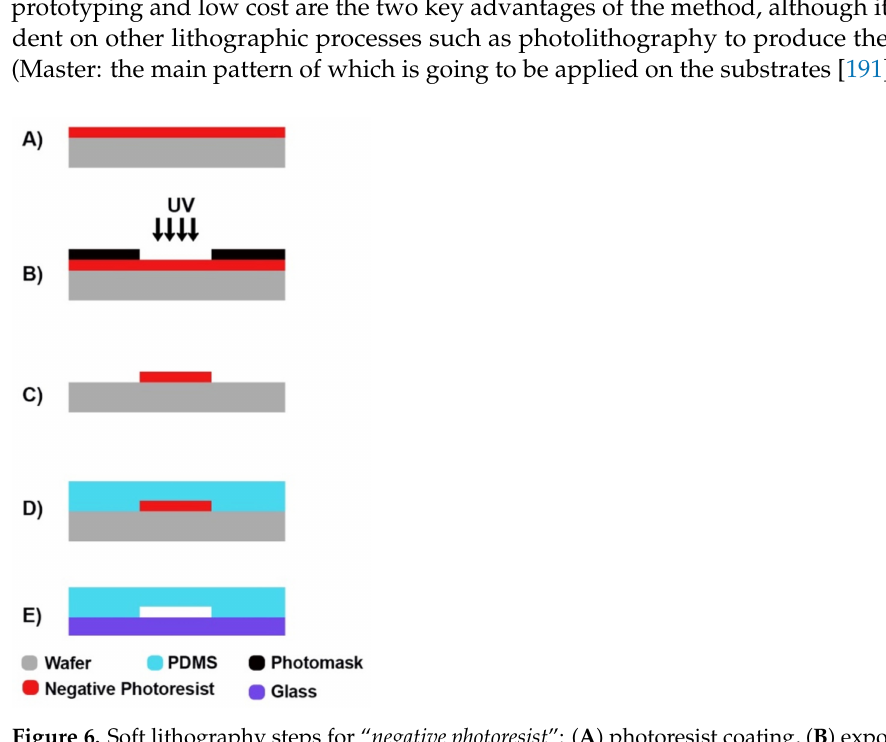
Figure 6. Soft lithography steps for “ negative photoresist ”: ( A ) photoresist coating, ( B ) exposure to UV light through photomask, ( C ) applying developer, ( D ) PDMS molding, and ( E )